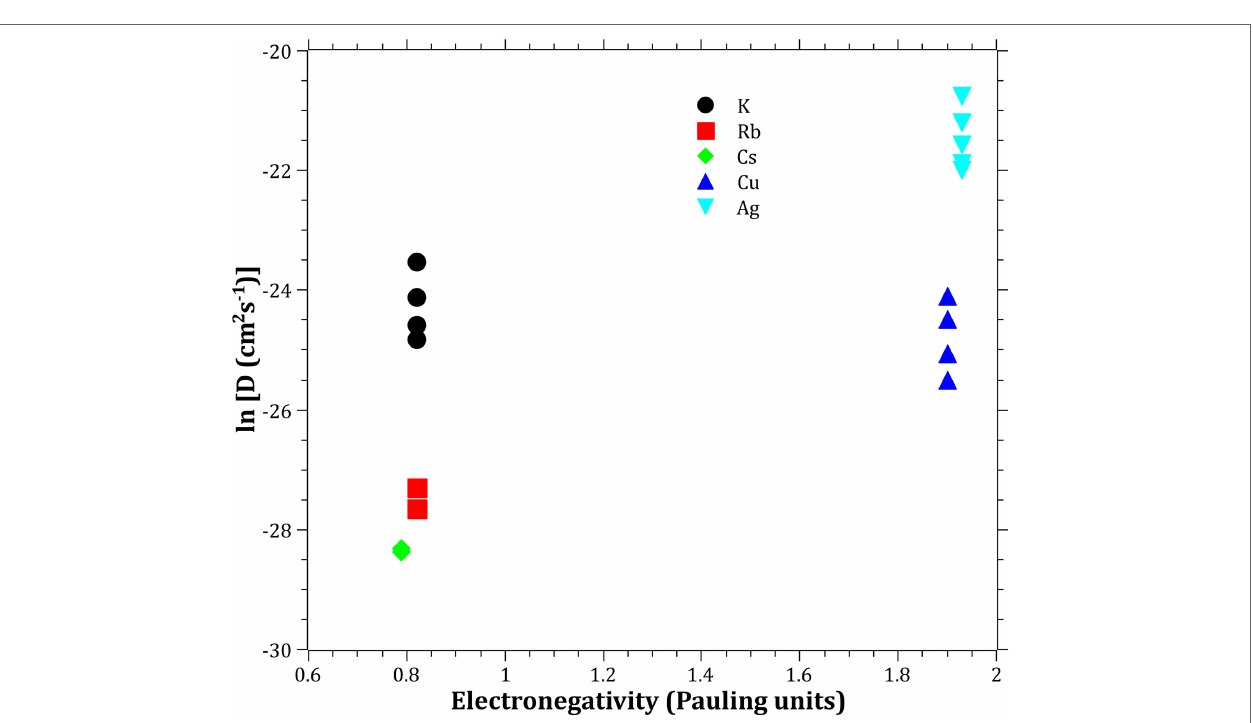
FiGUre 5 | Logarithm of the effective diffusion coefficient vs. electronegativity . Data taken from Dean (1999).